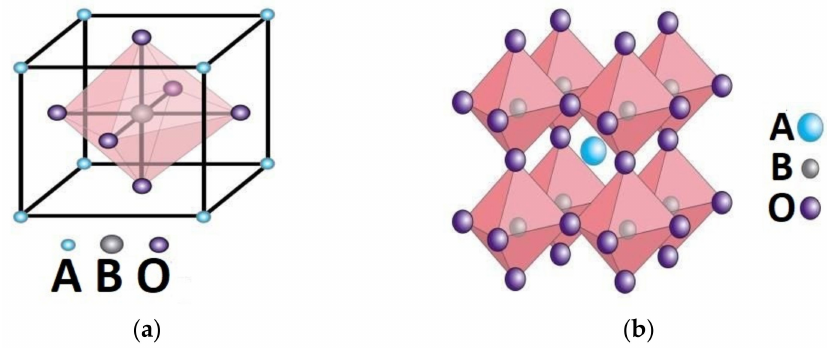
Figure 1. ( a ) Cubic mesh of perovskite; ( b ) three-dimensional (3D) stacking in the ideal cubic structure. Some distortions may occur in the ideal cubic structure, leading to orthorhombic, tetragonal, rhombohedral, or hexagonal